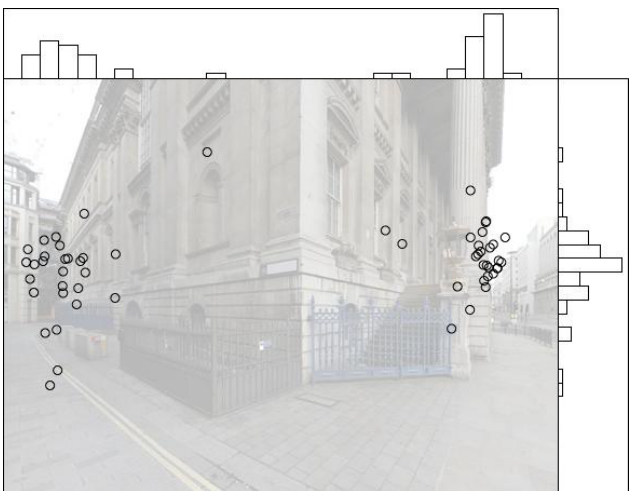
Figure 4. Example fixation data of all participants for one stimulus, with accompanying fixation density graphs.